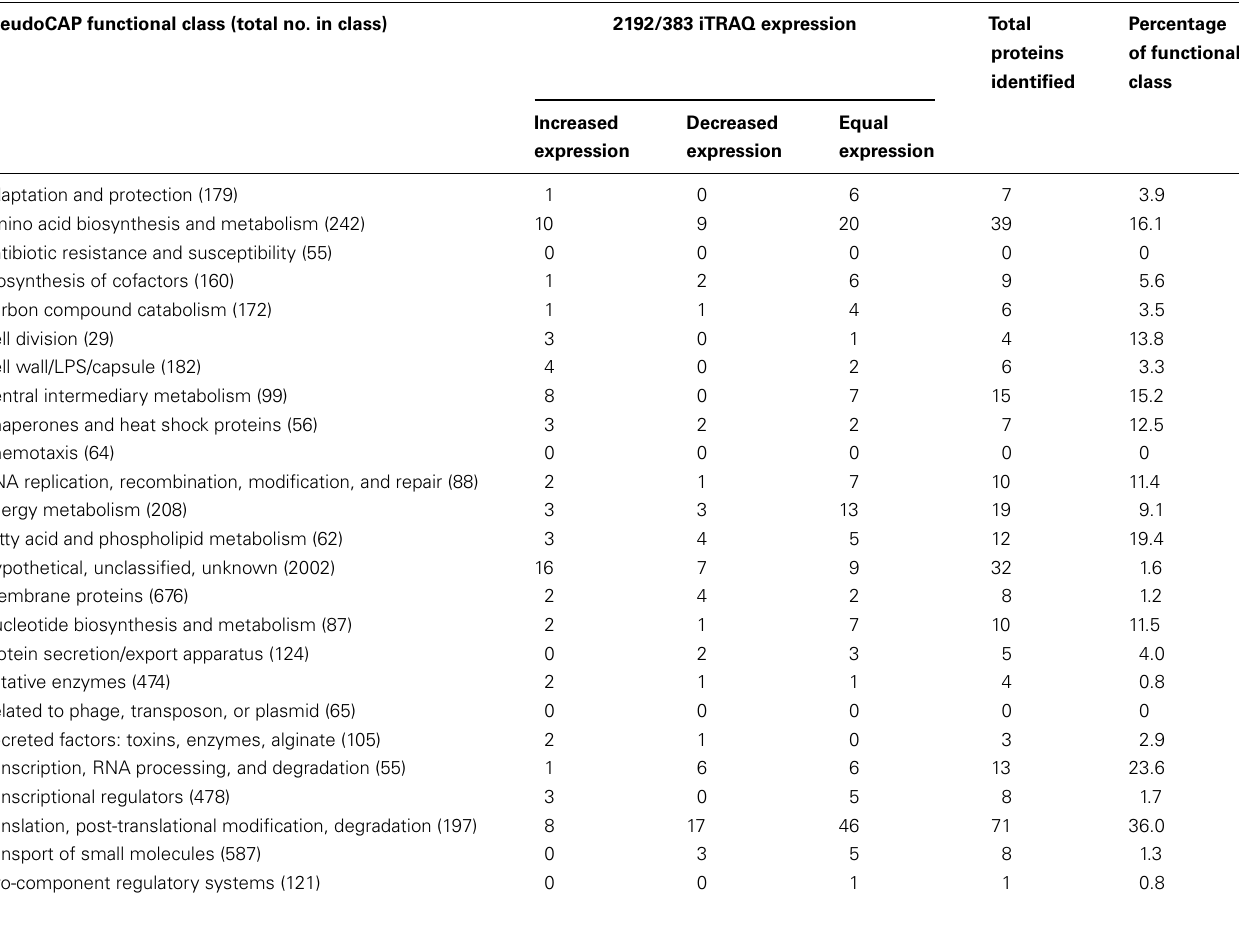
Table 1 | Distribution and PseudoCAP functional classification of proteins identified in CF strains 383 and 2192 by iTRAQ analysis. PseudoCAP functional class (total no. in